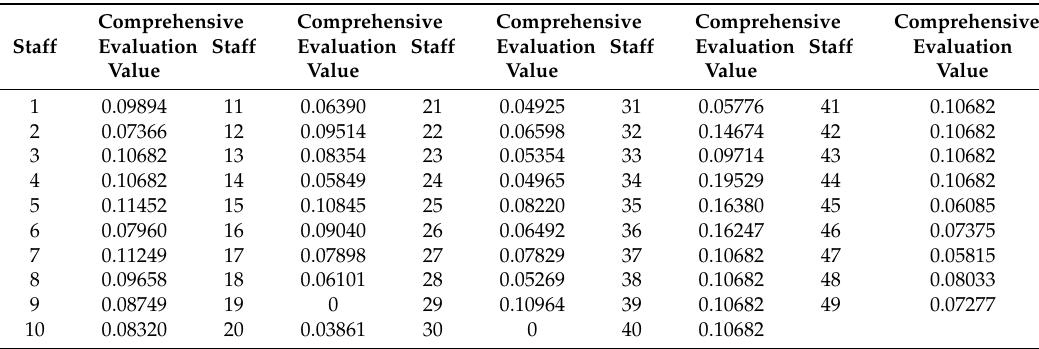
Table 8. Comprehensive evaluation of